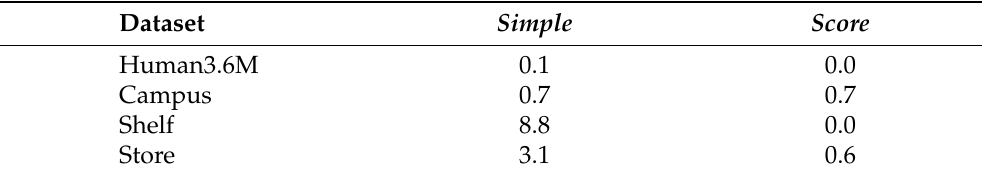
Table 1. SynErr results on Human3.6M, Campus, Shelf and Store